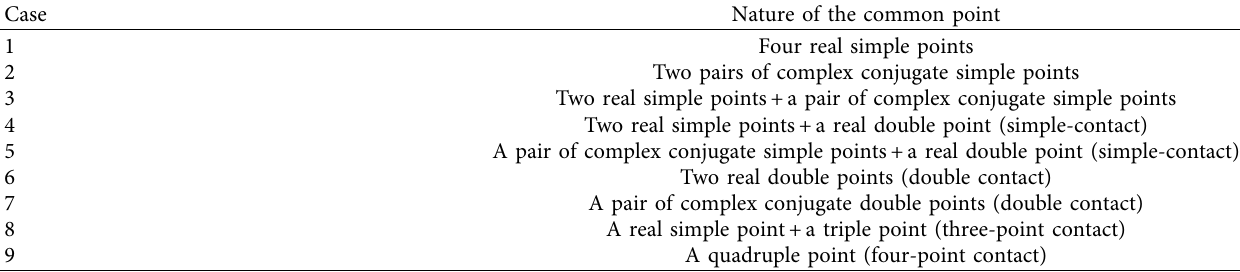
and the conic A 1